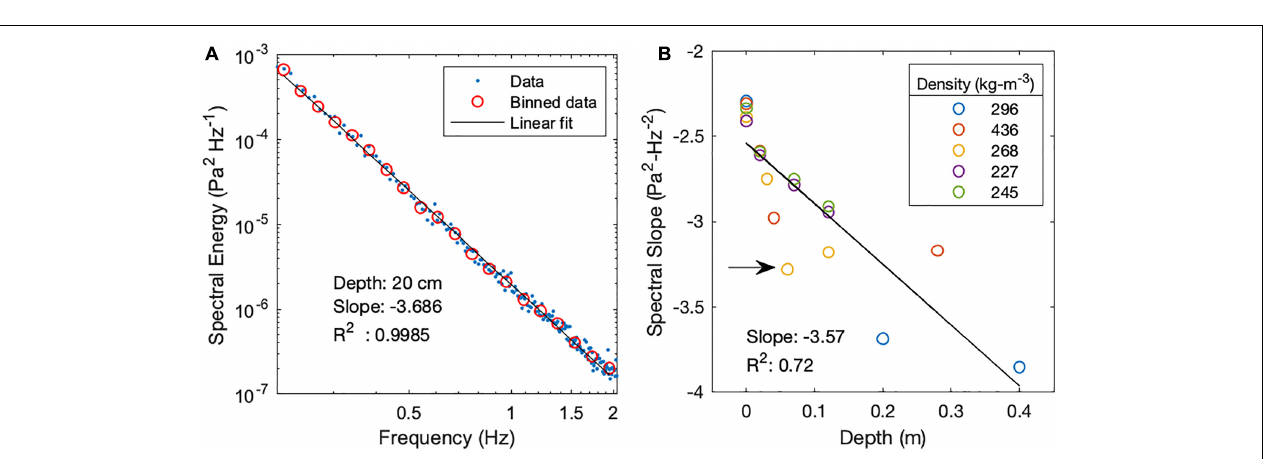
FIGURE 5 | Pressure spectra at 1 m above the snow (blue) and 6 cm below the snow surface (green and gold) for case 2 (panel A ), and at each depth for representative cases (panel B , see Table 1 ). Duplicate measurement depths in panel (A) delineate perturbation pressure reproducibility at frequencies below 4 Hz. The dashed line in panel (B) delineates the extent of frequencies and spectral energy that were used to analyze spectral power attenuation. For a homogenous layer, spectral energy measurements at a given depth (6 cm for case 2) are repeatable (panel A ).